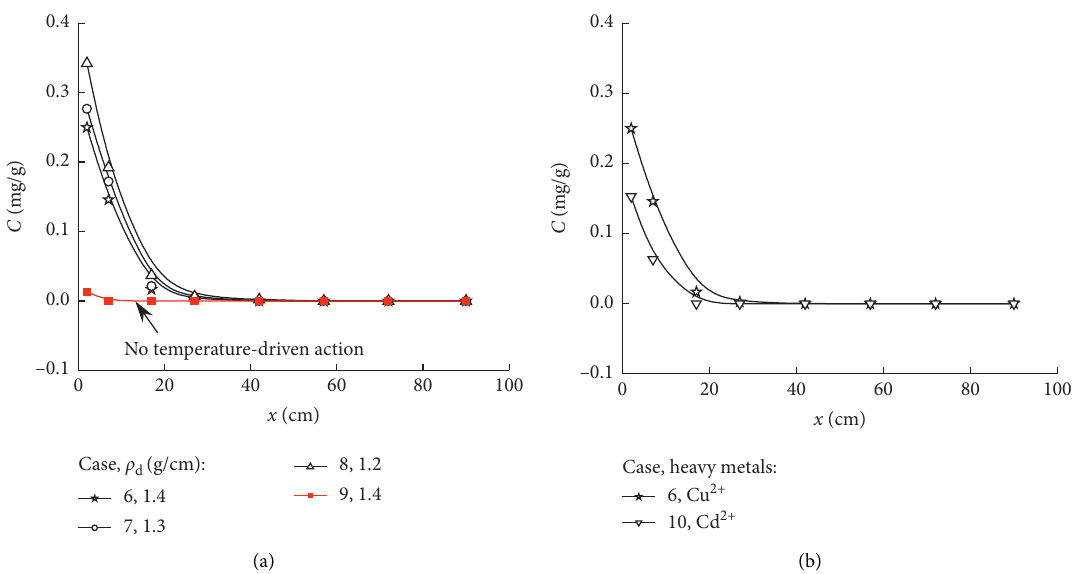
Figure 7: Concentration distributions of the heavy metal ions caused by the temperature: (a) effect of the dry density and (b) the different heavy